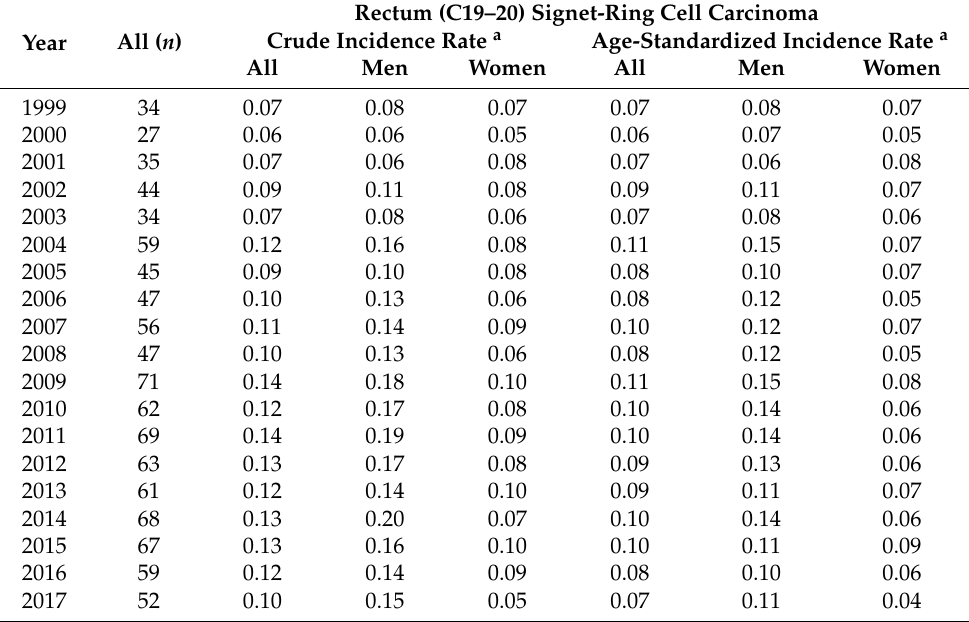
a Per 100,000 individuals.